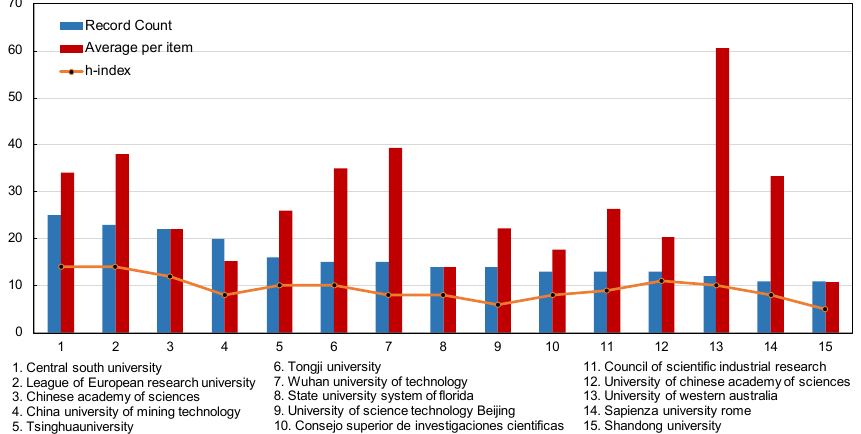
Figure 5. Growth trends of the top fifteen most productive institutions.